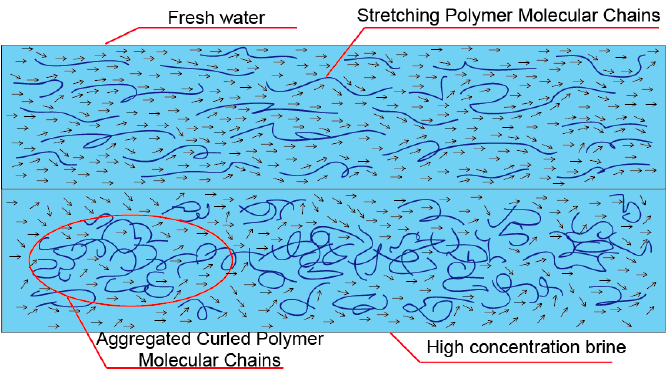
Figure 10. Schematic diagram of the difference in the morphological characteristics of the polymer molecular chains of the drag reducers in fresh water and brine.